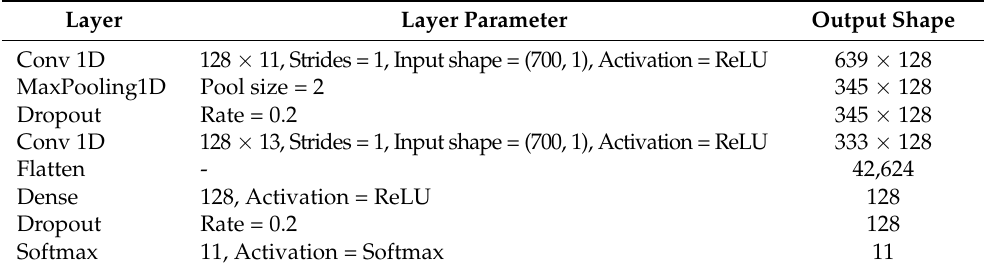
Table 2. CNN Model layer details.